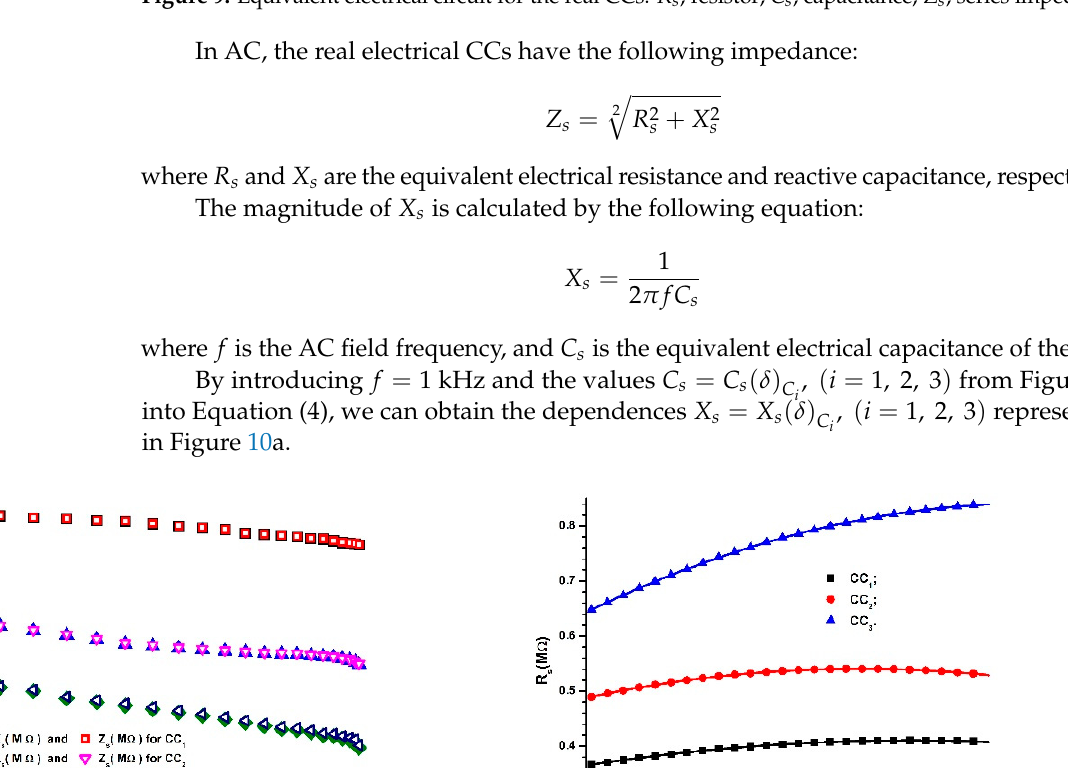
Figure 9. Equivalent electrical circuit for the real CCs: R s , resistor; C s , capacitance; Z s , series impedance.